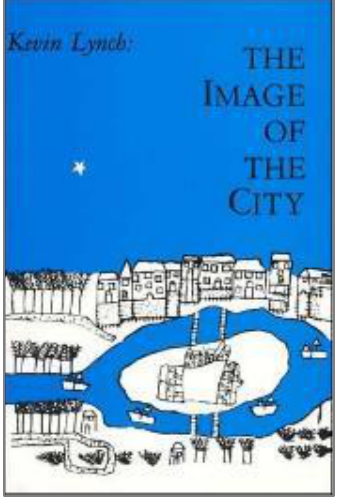
Figure 10 The Image of the City (Lynch, K., 1960)